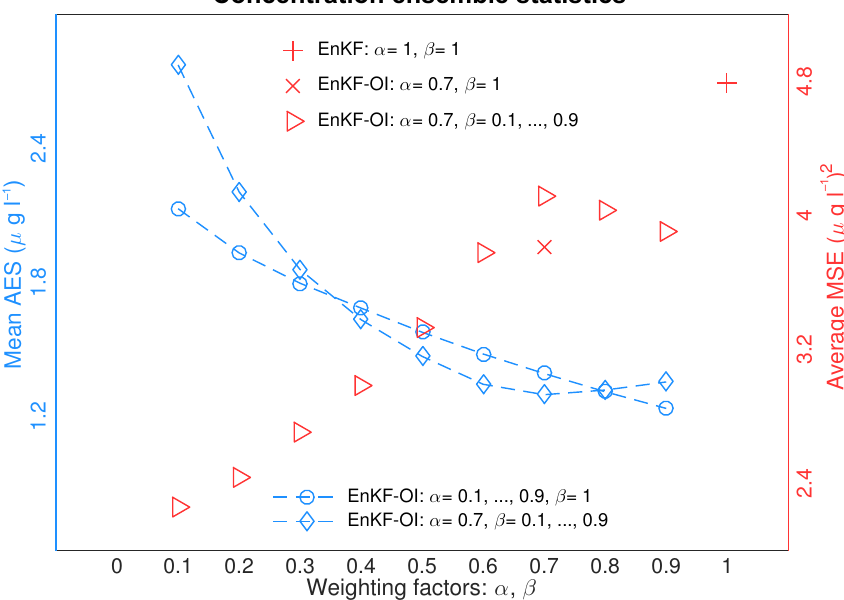
Figure 8. Left y axis: the AES of concentration ensemble obtained using the hybrid EnKF-OI by changing the individual weighting factors ( α and β ) between 0.1 and 0.9. Shown according to the right y axis the MSE obtained using the hybrid EnKF-OI β hybrid EnKF-OI α = 0 . 7 (cross) and the EnKF (plus).